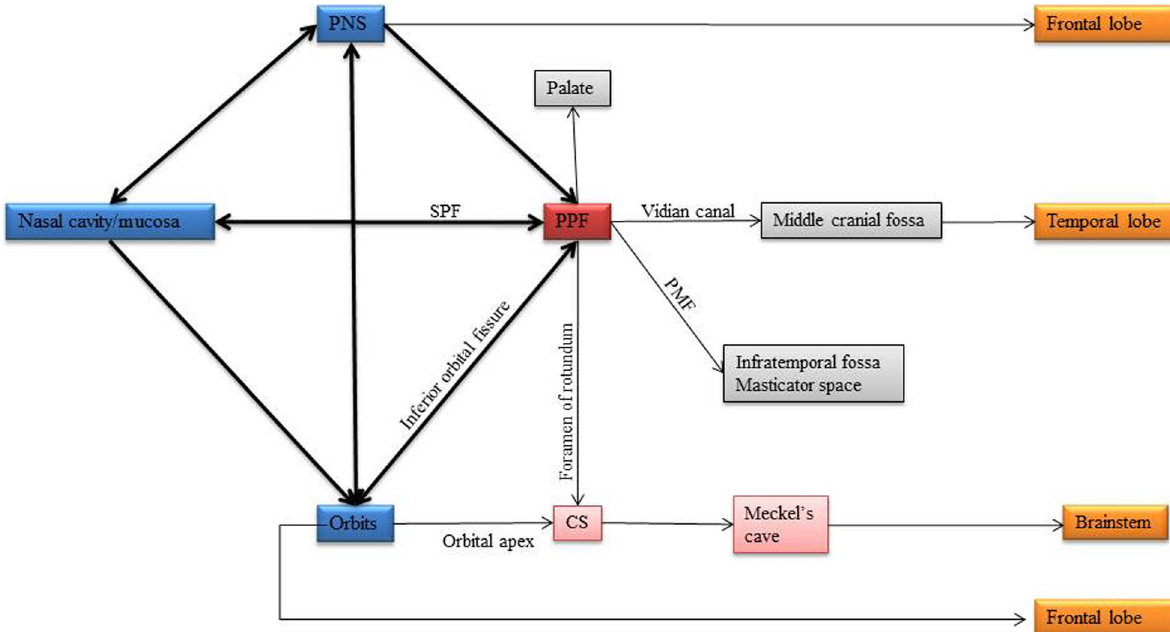
Fig. 12 Pathway of spread in invasive rhinosinusitis; PNS : paranasal sinus, SPF : sphenopalatine foramen, PPF : pterygopalatine fossa, CS : cavernous sinus, PMF : pterygomaxillary